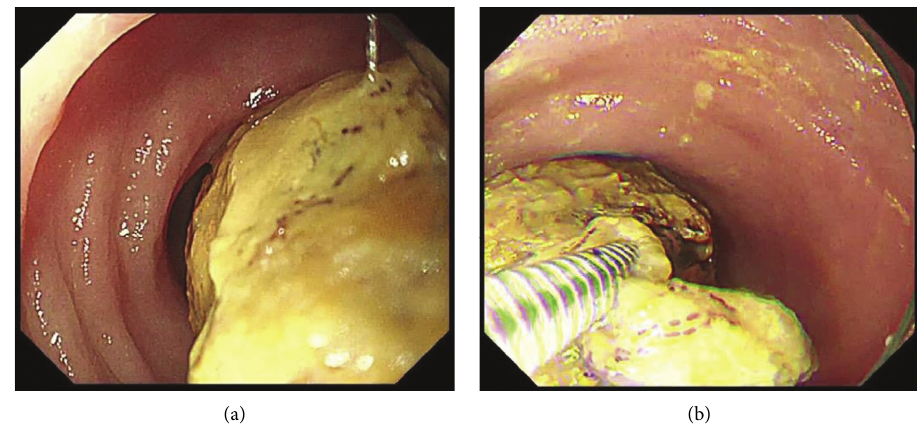
Figure 4: (a) A colonoscopy revealed a giant brown fecaloma occupying the lumen of the transverse colon. (b) Biopsy forceps splitted the fecaloma.